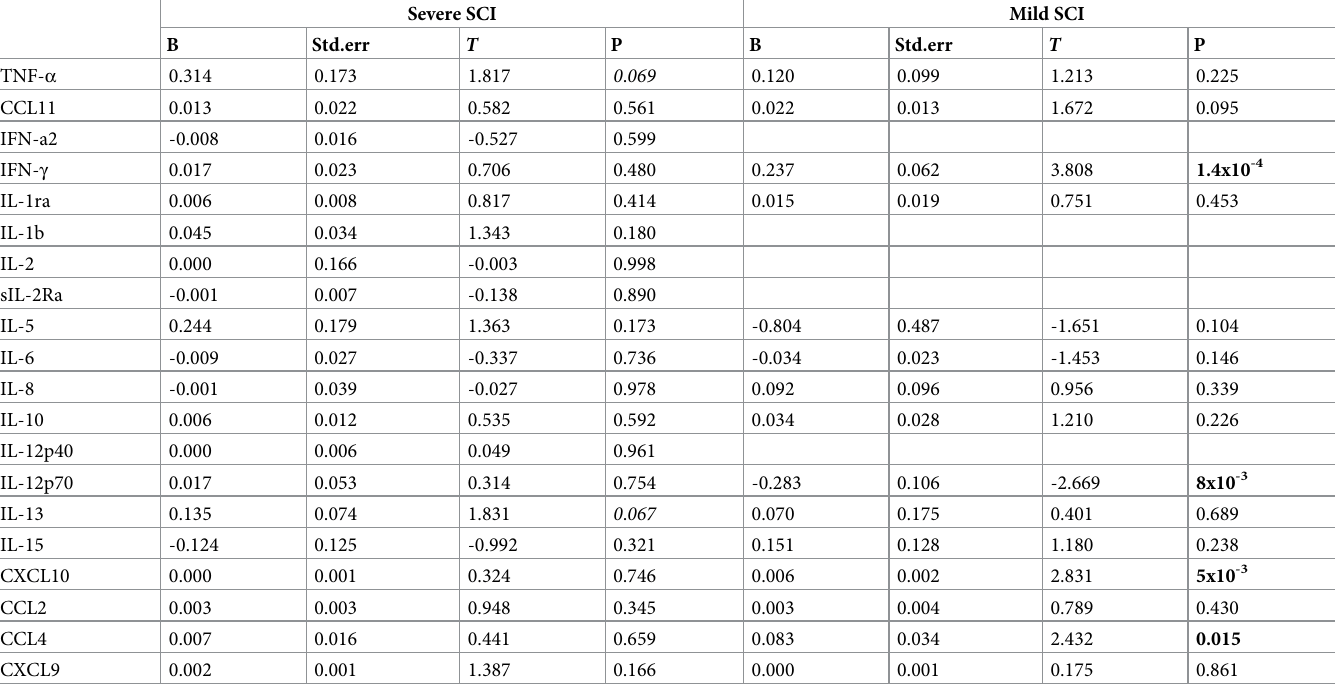
Table 6. Genetic effects on association of inflammatory mediators and braden scale.